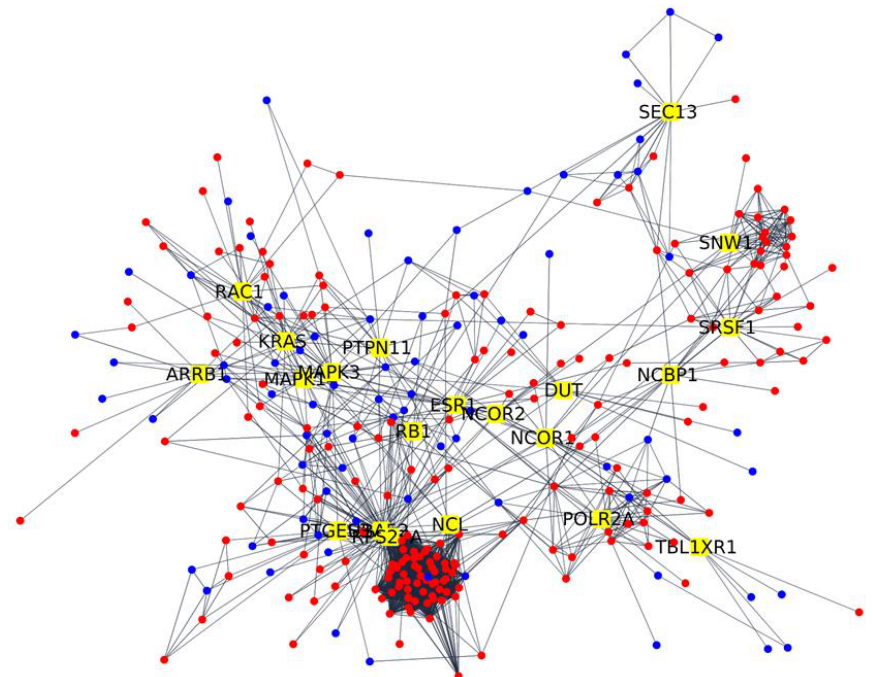
Figure 2. Network analysis of DEGs interacting with the 21 DEGs with the highest betweenness centrality. The network is composed of 265 nodes. The 21 key DEGs with the highest betweenness centrality are highlighted in yellow. The 244 interactor DEGs identified in the network are depicted in red if they are more expressed in the AD+COVID than AD cohort; otherwise, they appear in blue. To study the main sub-networks, we inspected the overrepresented biological pro- cesses in which the DEGs highlighted in Figure 1 are involved. We identified 205 overrepre- sented biological processes, and we focused on the 22 processes that are implicated in our study. As it is possible to observe in Figure 3, these processes are related to cell cycle, brain organization, immune response and oxidative stress. As expected, most of the processes are related to the immune